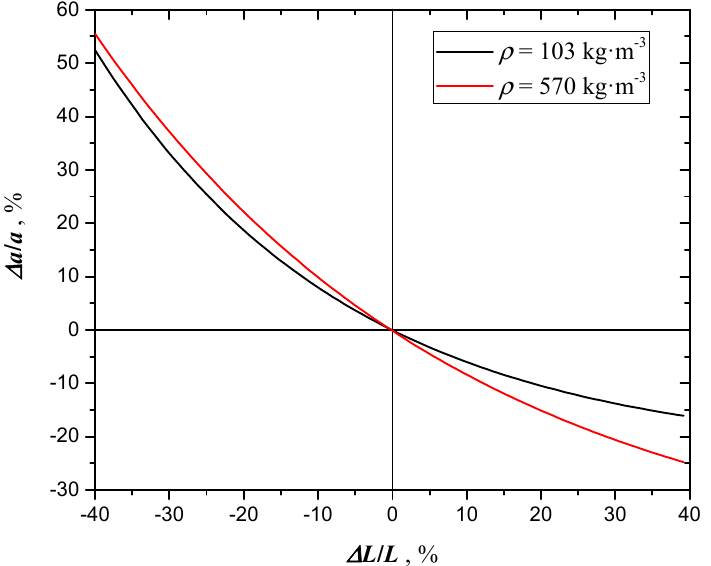
Figure 11. Relative deviation of a as a function of the relative deviation of sample thickness (at ρ = 570 kg ⋅ m − 3 ).